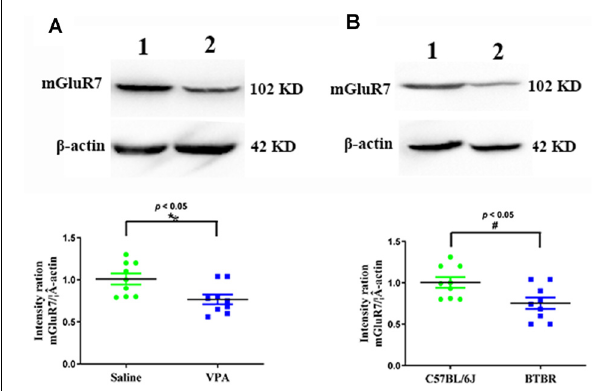
FIGURE 1 | Quantitative analyses of mGluR7 expression in the prefrontal cortex (PFC) of valproic acid (VPA)-exposed and BTBR mice. Western blots and corresponding densitometric quantification assessing mGluR7 expression in the PFC of VPA-treated and BTBR mice. (A) Lane 1, saline-exposed controls; Lane 2, VPA-treated animals. (B) Lane 1, C57BL/6J group; Lane 2, BTBR group. Data are normalized to mGluR7 expression in control animals (100%). β -actin was a normalization control. n = 6 mice per group. * p < 0.05 vs. saline-treated controls. # p < 0.05 vs. C57BL/6J group. The Student’s t -test assessed statistical significance. Data are means ±